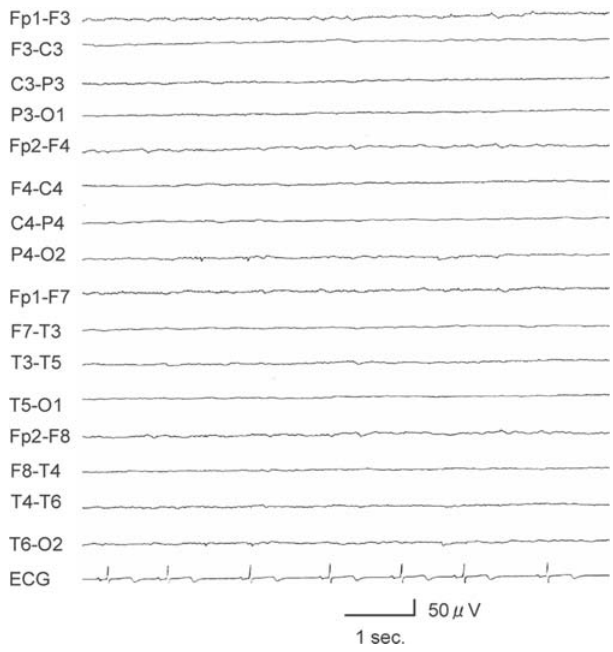
Figure 2. An awake electroencephalogram of a 6-year-old boy (indicated with * in Table 1). He had extremely low activity in all areas of cerebral cortex. damage. No patients exhibiting residual voluntary movements of their extremities performed oral imitation.